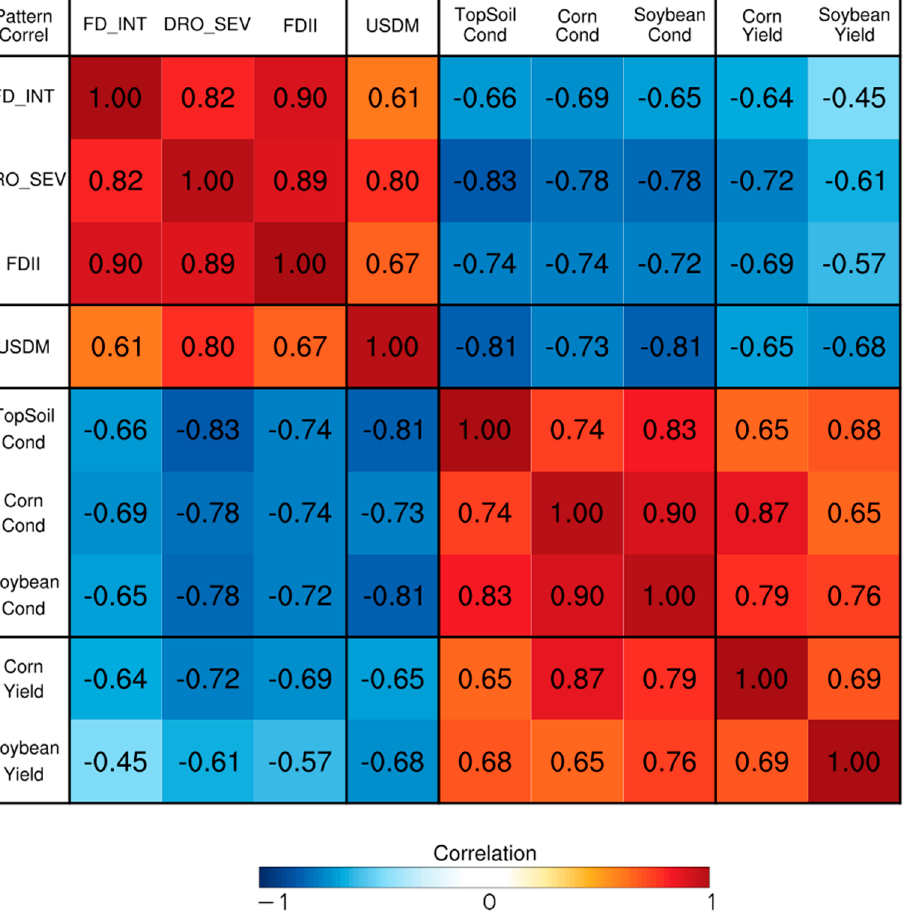
Figure 6. Matrix showing the Pearson correlation coefficients computed between different variables including the maximum FD_INT, DRO_SEV, and FDII between 1 May and 18 August 2012, the USDM drought analysis and NASS topsoil moisture, corn, and soybean condition anomalies on 18 August 2012, and trend-adjusted corn and soybean yield departures for 2012 using data from the region shown on Figure 5.